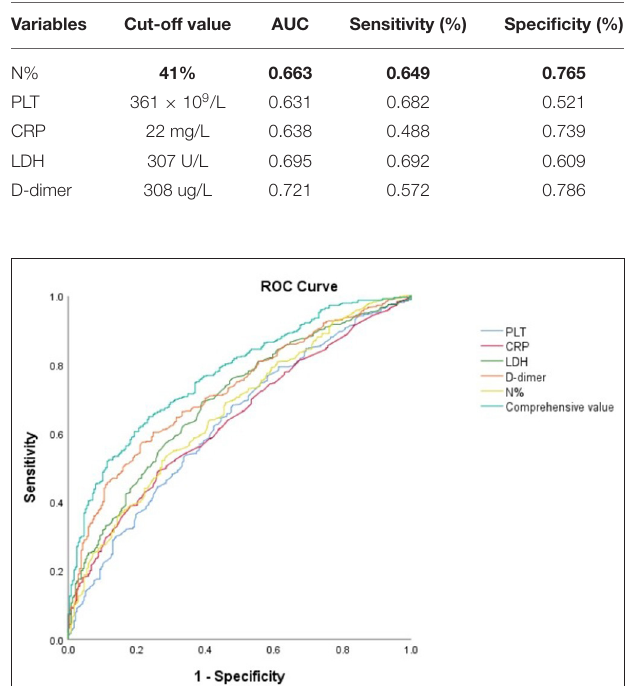
TABLE 3 | Cut off value between SMPP and NSMPP.